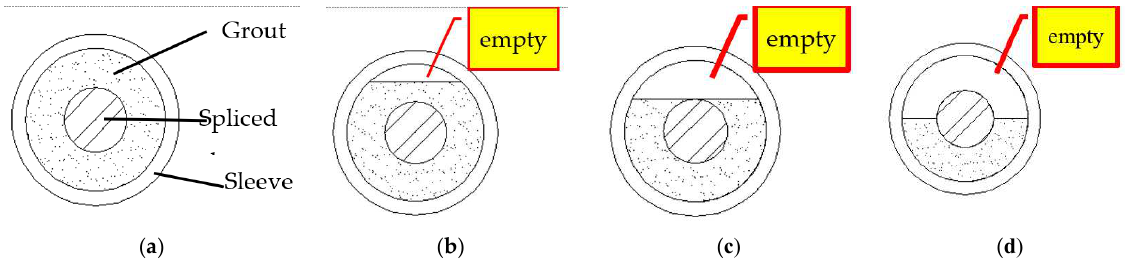
Figure 3. Schematic diagrams of different grout compactness. ( a ) 100% compactness. ( b ) 90% compactness. ( c ) 70% com- pactness. ( d ) 50% compactness.